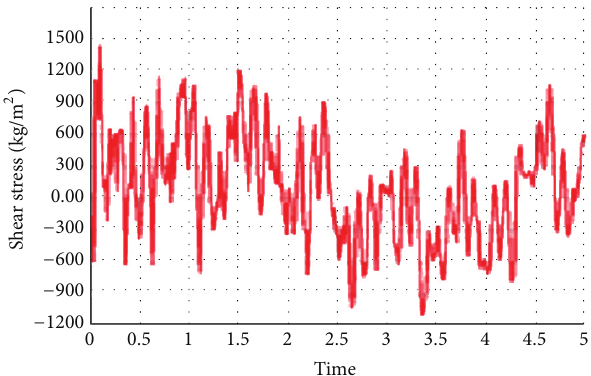
Figure 6: Shear stress in point 4 from model 1; vertical axis is value of shear stress, and horizontal axis is time of earthquake.